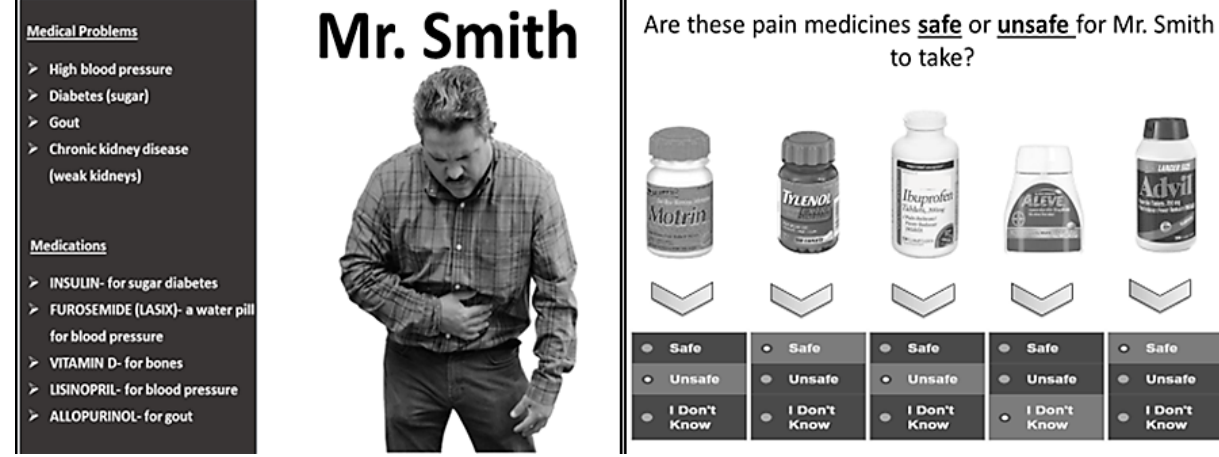
Figure 1. Example of an educational tool